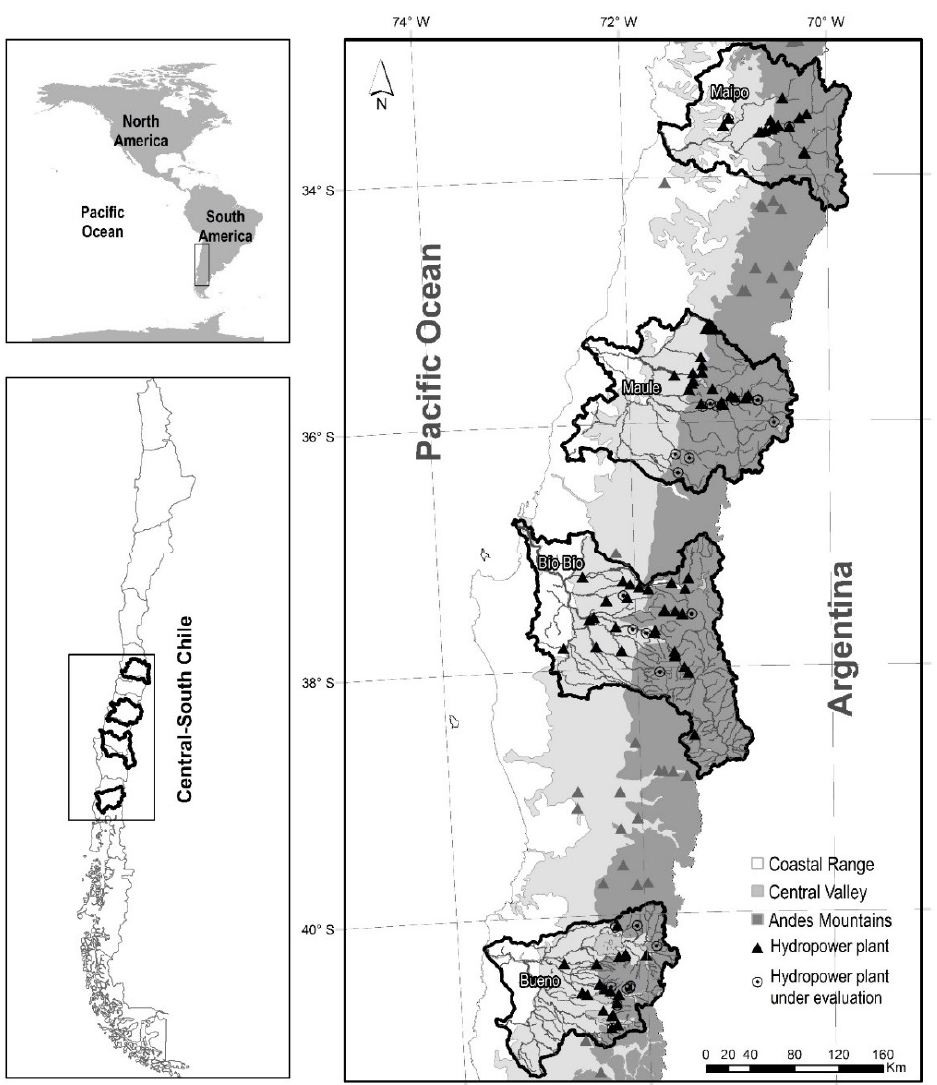
Figure 2. Location of the study area and installed and planned hydropower plants. 161 Table 1. Location, geomorphological and climate data for each basin in the study